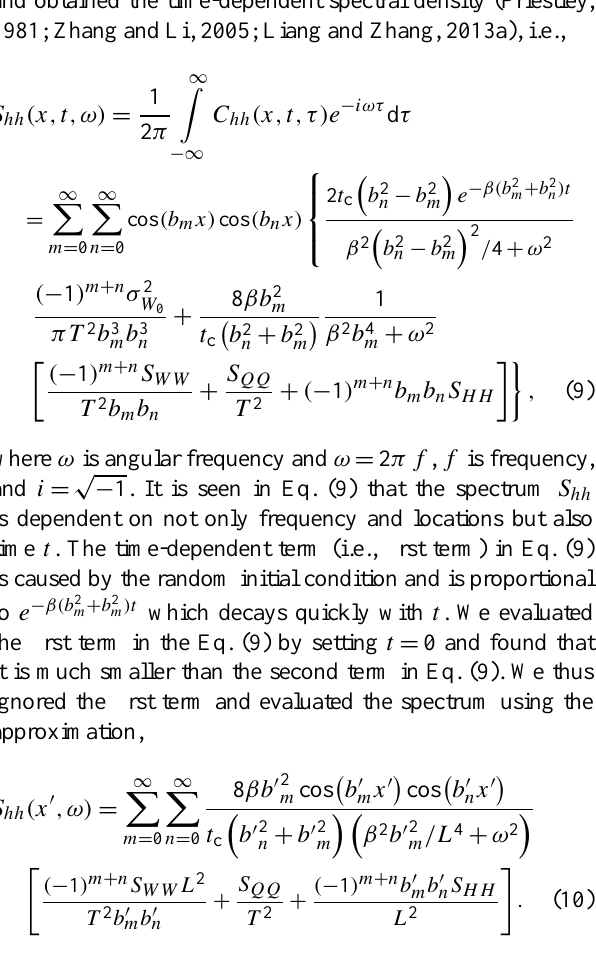
Figure 2. The graphs on the left column show the standard de- viation ( σ (cid:48) ) of groundwater level ( h(x , t )) versus the dimension- h less time ( t (cid:48) ) at the dimensionless locations x (cid:48) = 0.0, 0.2, 0.4, 0.6, and 0.8. The graphs on the right column show σ (cid:48) versus x (cid:48) for h the different t (cid:48) : panels (b) and (d) show t (cid:48) = 0.0, 0.2, 0.4, 0.6, and 0.8, panels (f) and (h) show t (cid:48) = 0.01, 0.1, and 1.0, and panel (j) shows t (cid:48) = 0.01, 0.2, 0.4, 0.6, and 0.8. Also, (a) and (b) are = σ 2 = σ 2 = 0; (c) and (d) are based based on Eq. (11) where σ 2 W Q H = σ 2 = σ 2 = 0; (e) and (f) are based on on Eq. (12) where σ 2 W 0 Q H = σ 2 = σ 2 = 0; (g) and (h) are based Eq. (13) where σ 2 W 0 W H